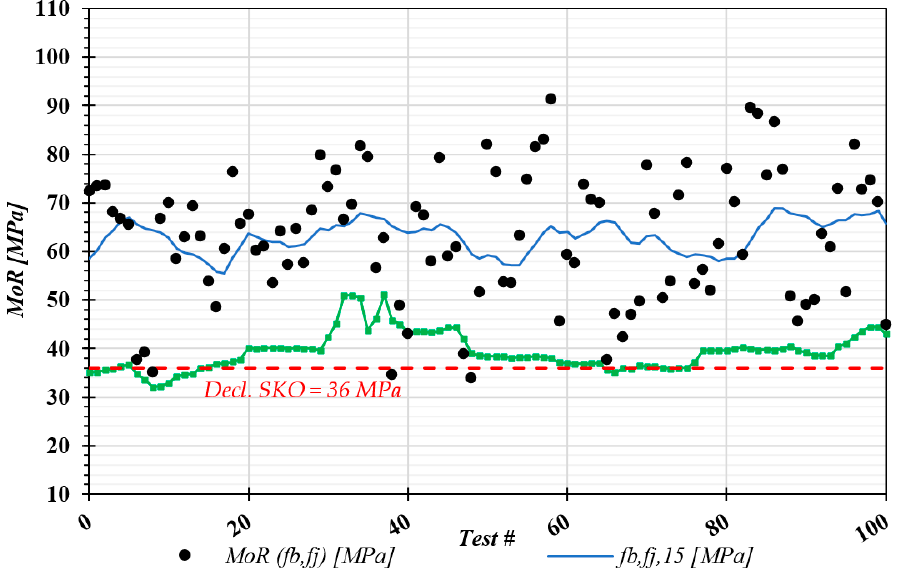
Figure 7. Bending strength of finger-jointed timber over 100 tests (finger length = 15 mm).